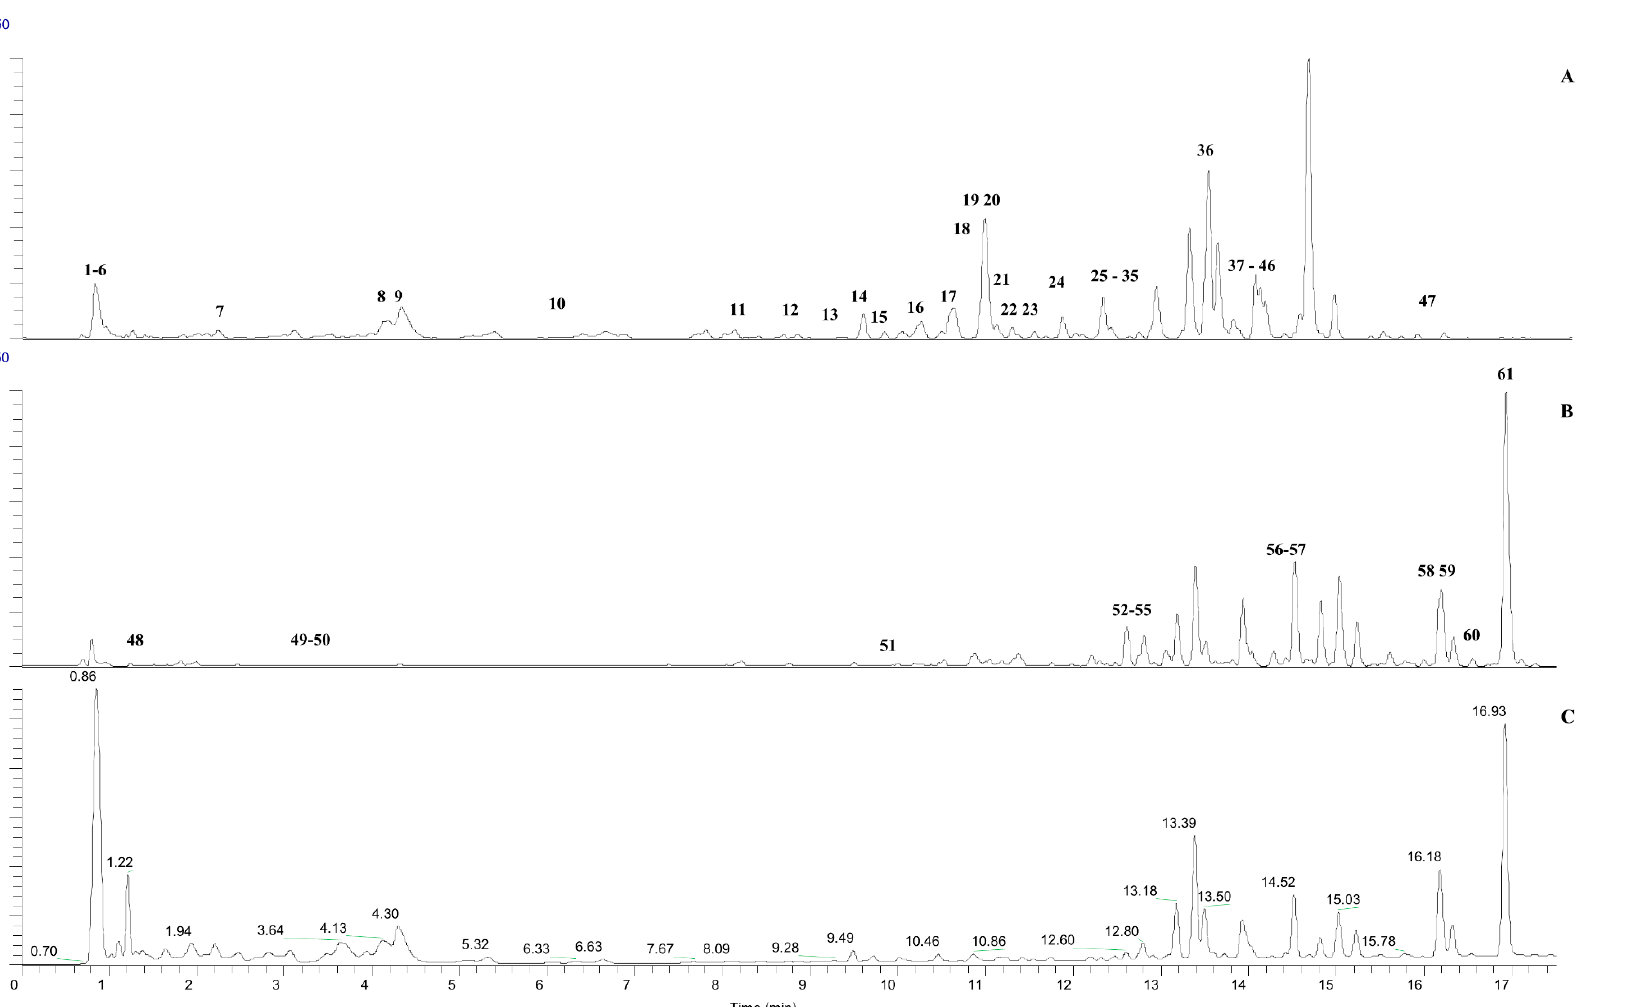
Figure 1. Total ion chromatogram (TIC) and UV-Vis chromatogram (254 nm) ( C ) of M. calabura FD leaves extracted with 50% ethanol in negative ( A ) and positive ion mode ( B ), respectively.